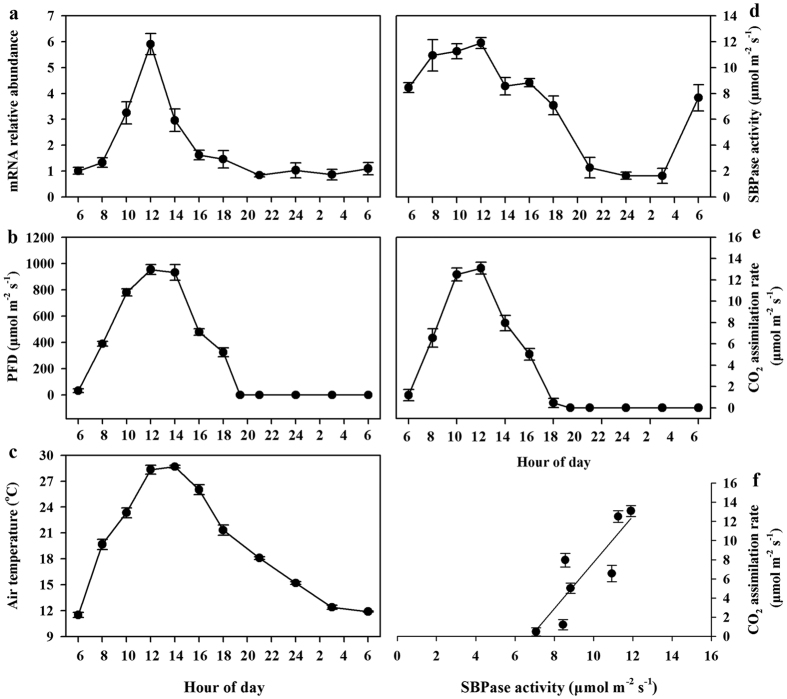
Diurnal changes in SlSBPase mRNA abundance, SBPase activity, CO2 assimilation rate, PFD and air temperature measured in greenhouse conditions on three consecutive sunny days.All measurements were done on 20-leaf tomato plants. (a) SlSBPase mRNA abundance was analyzed by quantitative real-time PCR using total RNA isolated from the fully expanded leaves (leaf no. 13–15 from base) at 2-h intervals. (b) Diurnal variation of PFD in greenhouse. (c) Diurnal variation of air temperature in greenhouse. (d) SBPase activity was assayed using the same tissues for SlSBPase mRNA analysis. (e) Measurements of CO2 assimilation rate were made on the fully expanded leaves (leaf no. 13–15) at 2-h intervals. (f) CO2 assimilation rates were plotted against levels of SBPase activity, showing the correlation between them. The results are the means ± SDs (n = 4).